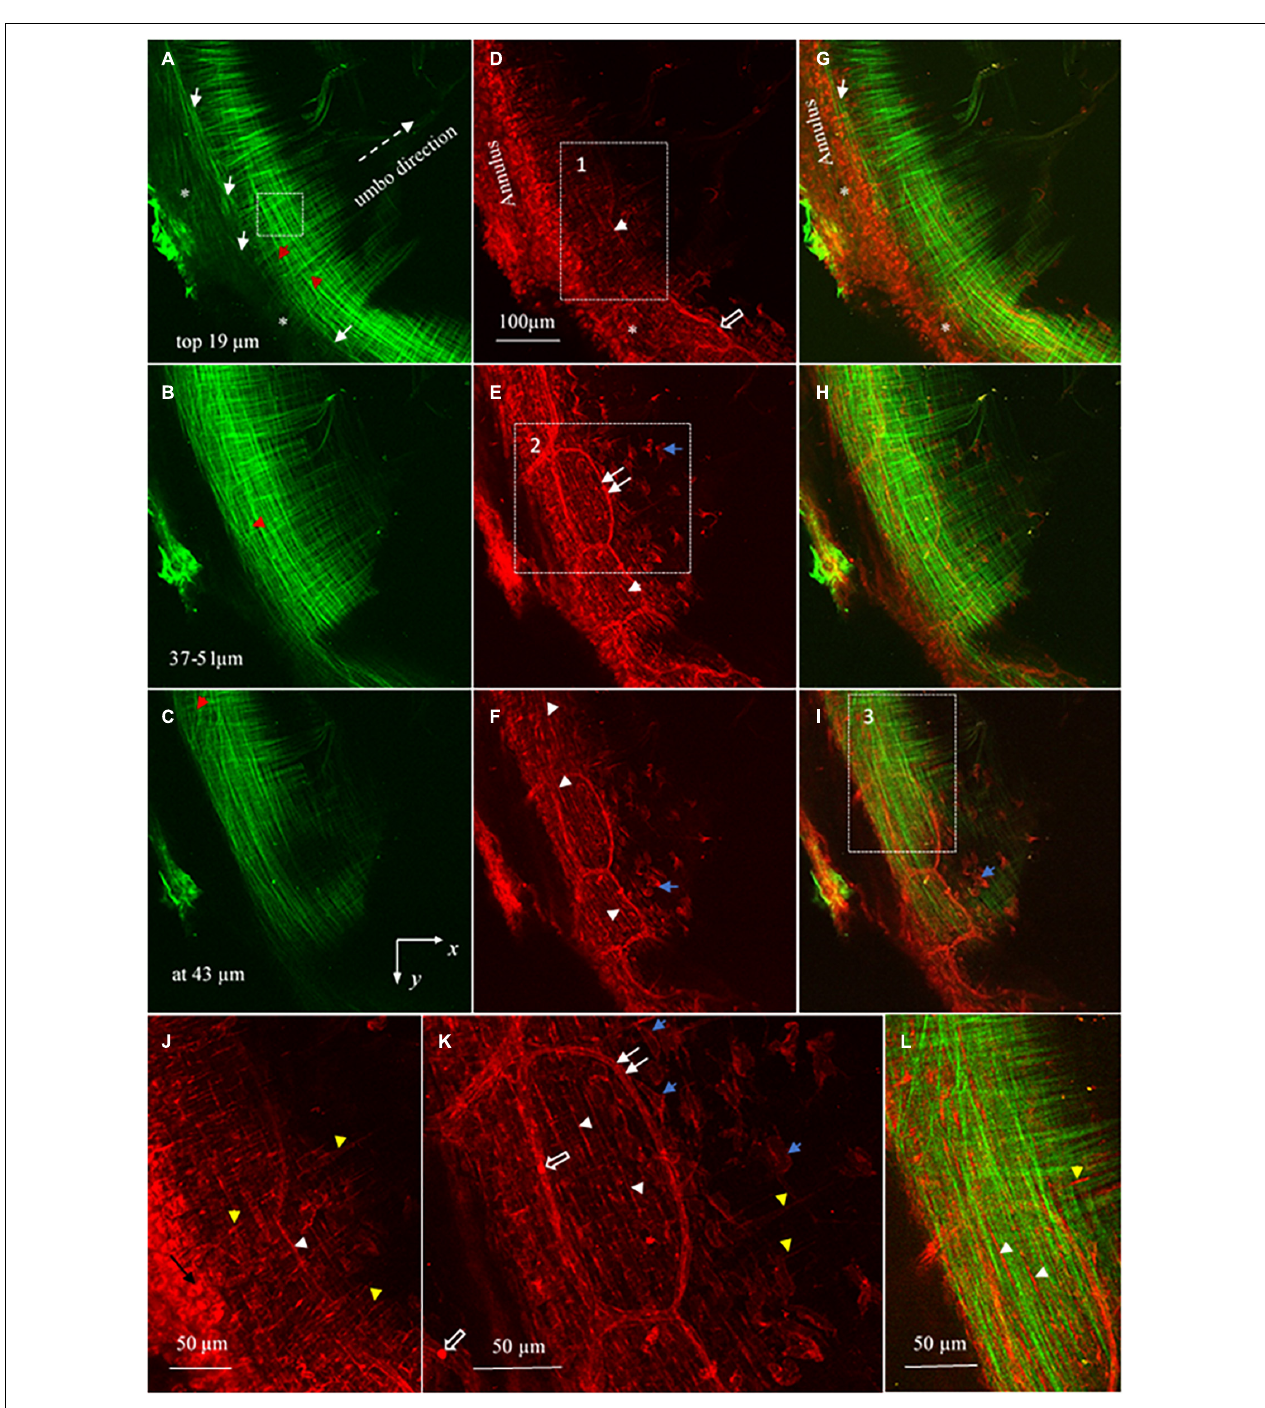
FIGURE 4 | Maximum brightness images of the pars tensa annulus unit. (A–C) Maximum brightness images of SHG at different depths across the thickness of the pars tensa-annulus unit confirm that the collagen fibers constituting the parse tensa orient predominantly in the radial and circumferential direction, and the pars tensa and annulus are connected by collagen [* and white arrows, panels (A,G) ]. Nevertheless, oblique and parabolic collagen fibers (red arrowheads) exist among the predominant radial and circumferential fibers. (D–F) The corresponding MBIs from TPF show the elastic fibers (white arrowheads), capillaries (double white arrows) with the hemoglobin (hollow arrow), vimentin positive cells (blue arrows) and annulus chondrocytes in the pars tensa-annulus unit. (G–I) The merged images highlight the integration of the collagen (green) with the chondrocytes, capillaries and vimentin cells (blue arrows) in the pars tensa-annulus unit. (J) An enlarged image extracted from region 1 in panel (D) showing in more detail the radial (yellow arrowheads) and circumferential (white arrowheads) elastic fibers and chondrocytes (black arrow) in the pars tensa–annulus unit. (K) An enlarged image extracted from region 2 in panel (E) showing in more detail the